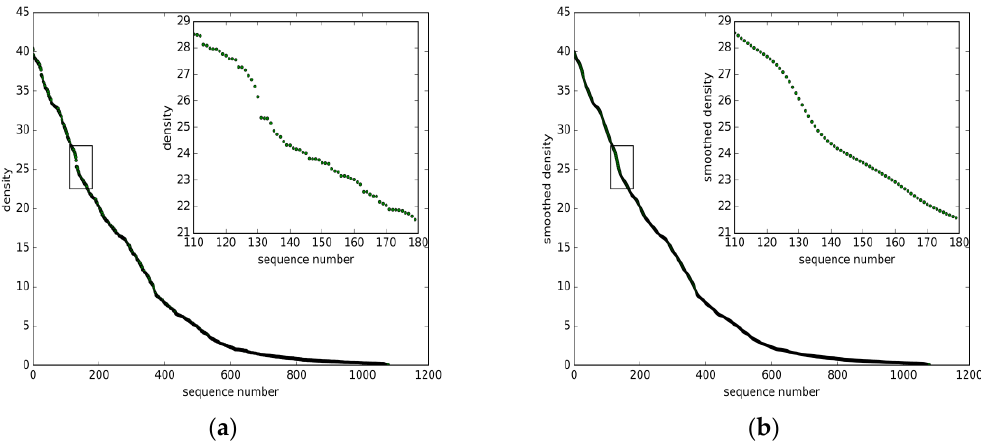
Figure 4. Density sequence. ( a ) Non-smoothed density sequence and ( b ) smoothed density sequence.